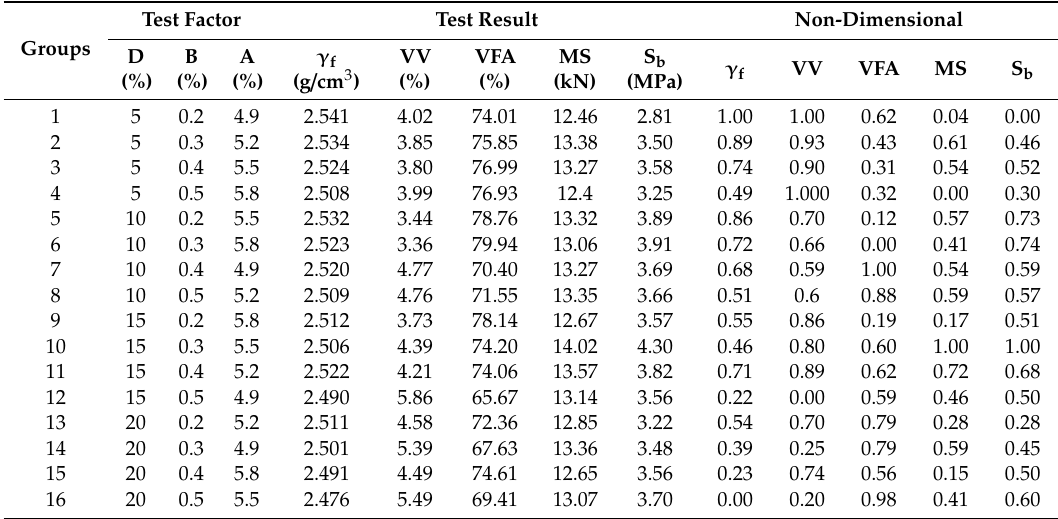
Table 6. L 16 (4 3 ) orthogonal array and the